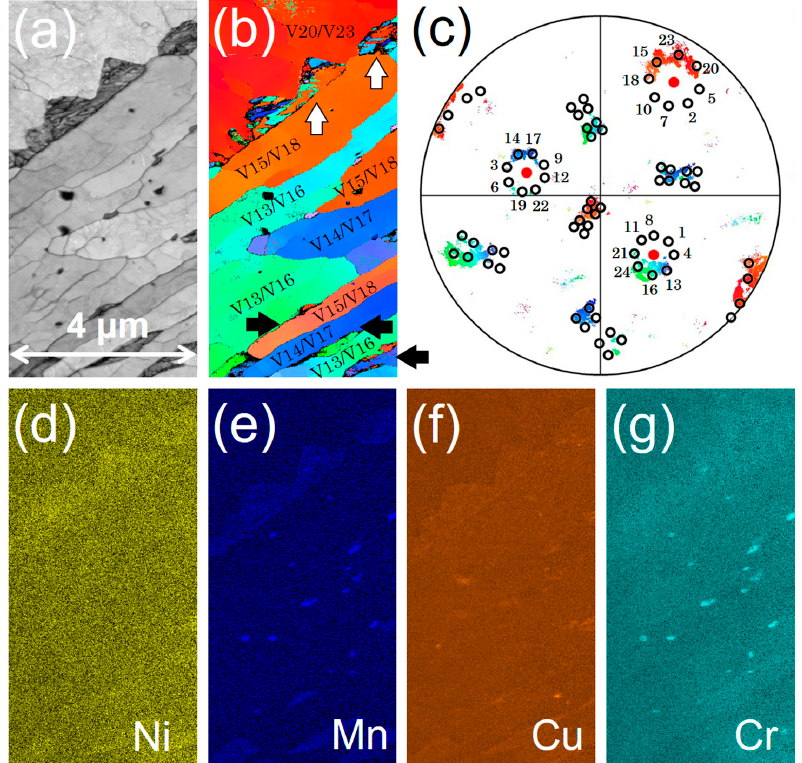
Figure 7. Transmission Kikuchi diffraction (TKD) mapping showing ( a ) band contrast, ( b ) inverse pole figure—Z, ( c ) experimental and simulated pole figures, ( d ) Ni distribution, ( e ) Mn distribution, ( f ) Cu distribution, and ( g ) Cr distribution in S690Q steel after tempering at 720 °C. Table 2. The twenty-four crystallographic variants for Kurdjumov-Sachs (KS) orientation relationship evolved from a single austenite grain.